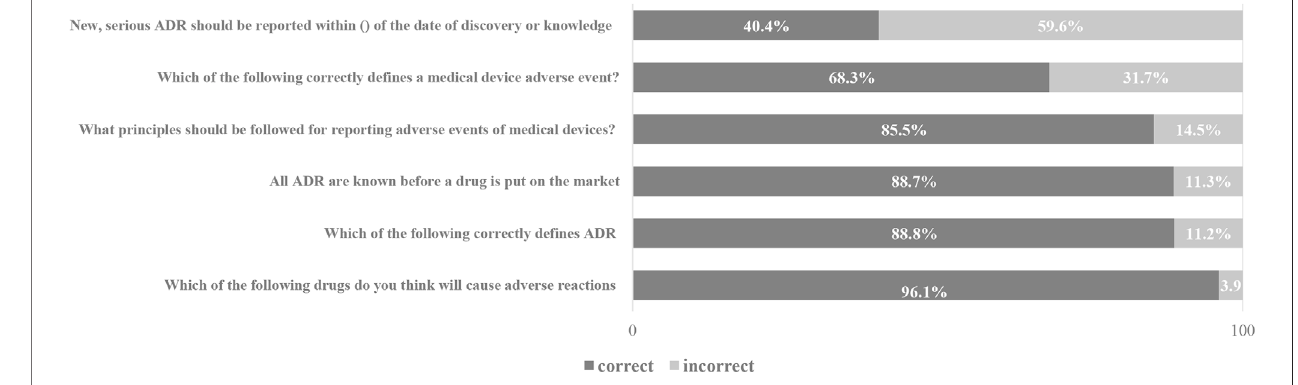
FIGURE 1 | Knowledge of pharmacists toward